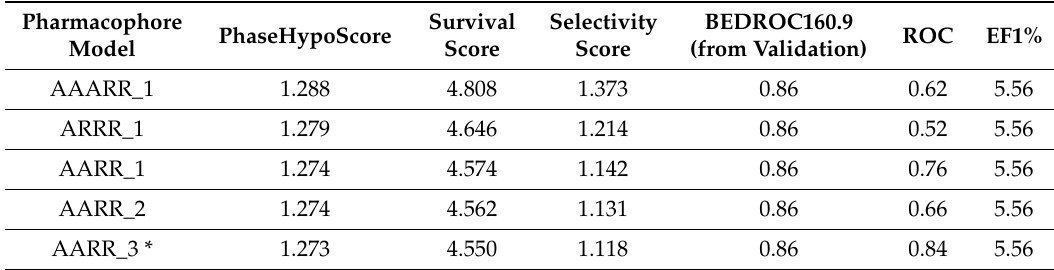
Table 11. Top 5 pharmacophore hypotheses for the 3,1-benzoxazin-4-one set. A–acceptor group; R–aromatic